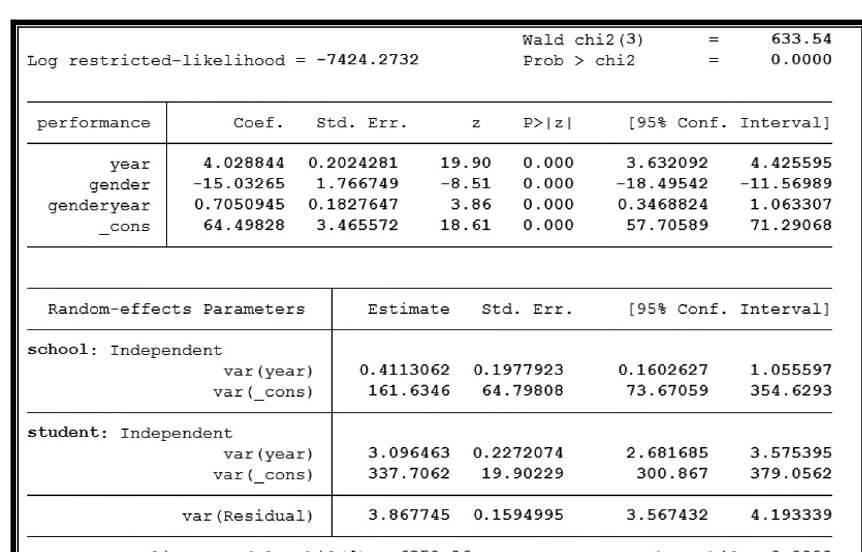
Figure 11. Linear trend model with random intercepts and slopes and Level-2